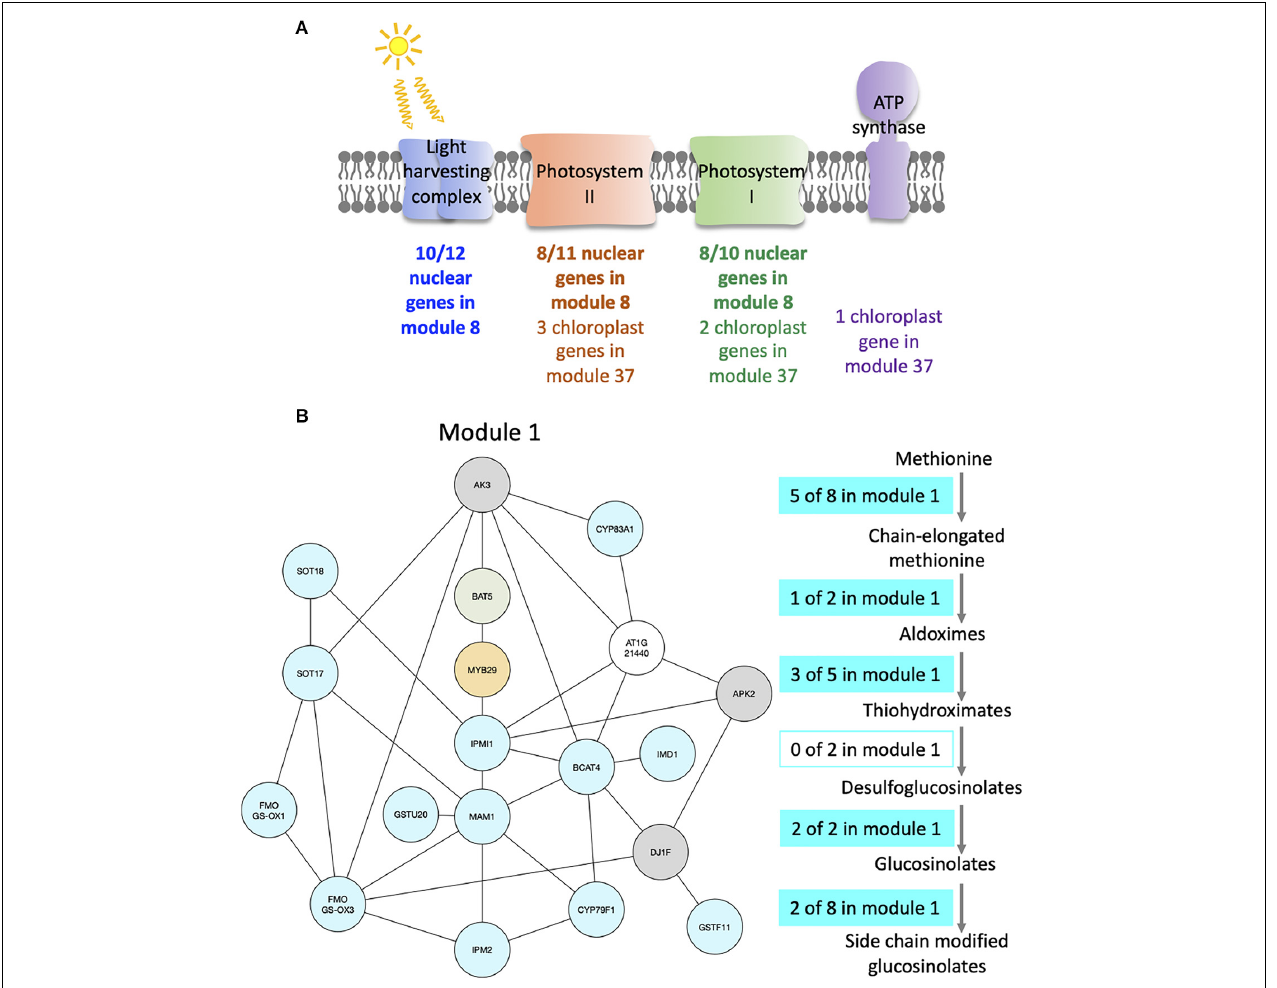
FIGURE 4 | Modules enriched in genes involved in the photosynthesis and the glucosinolate pathway. (A) Functional analysis of modules 8 and 37. For each module, the number of genes that are part of photosystem I (green), photosystem II (orange), the light harvesting complex (blue), or the ATP synthase (purple) is indicated. (B) Functional analysis of module 1. Genes of the module are color coded depending on their role in the glucosinolate pathway: biosynthesis (turquoise), transport (green), or regulation (orange). Genes previously identified as co-expressed with glucosinolate biosynthesis genes are also indicated (gray). On the right side, the glucosinolate biosynthesis pathway is shown with an indication of the number of genes present in module 1 at each step of the